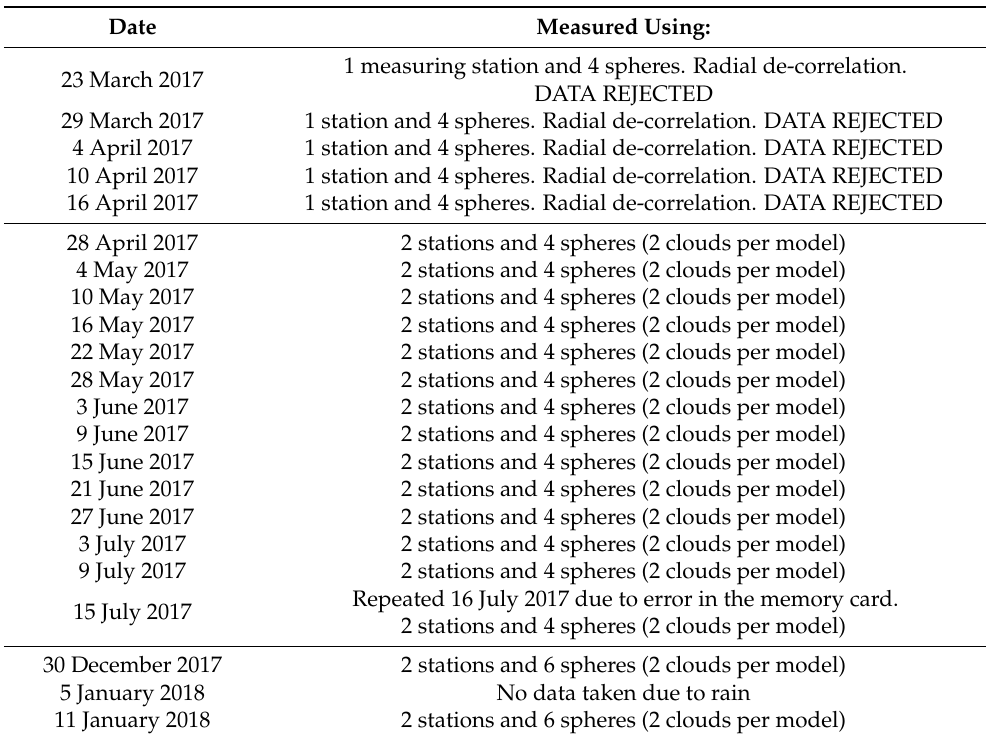
Table 3. Characteristics of LIDAR data collection used.